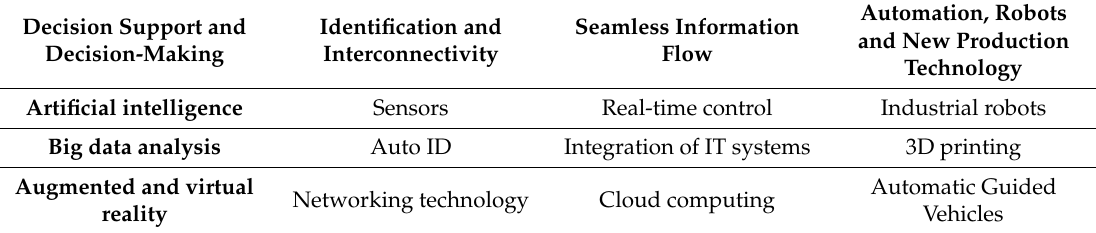
Table 1. Industry 4.0 technologies for